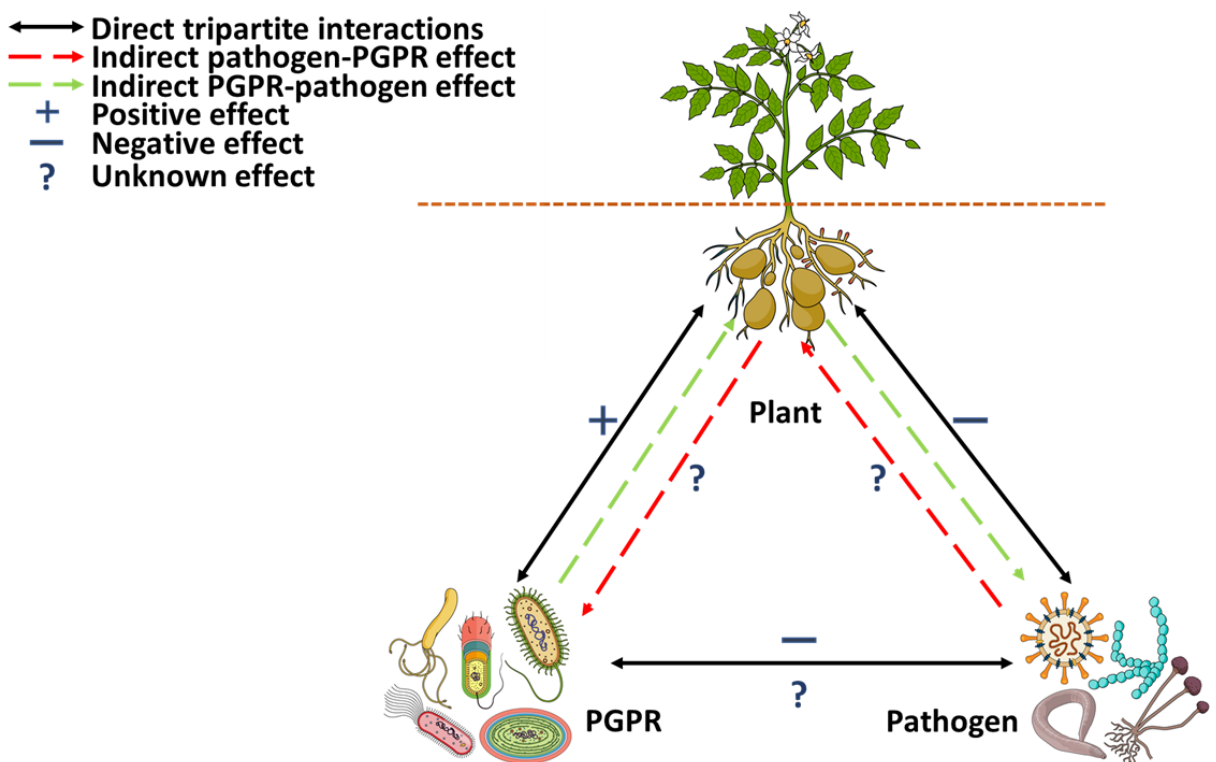
Figure 5. Direct and indirect tripartite interactions of plants, pathogens and PGPR. During direct tripartite interactions belowground (rhizospheric), plant – PGPR interactions result in positive effects on both parties; plant root exudates recruit and cater carbon-rich organic compounds for the proliferation of beneficial microbes (PGPR), while the microbes influence plant growth and protection. At the same time, plant – pathogen and pathogen – PGPR interactions result in negative and some unknown effects. Indirect tripartite interactions (ITI) are plant-mediated interactions between PGPR and aboveground pathogens. A negative effect on the plant by a pathogen (red dotted lines) triggers a physiological and metabolic change that causes the plant to recruit PGPR for defence. A response from the PGPR (green dotted lines) modifies the plant’s defence mechanism to improve resistance or tolerance against the foliar pathogen. Some of the underlying mechanisms of these interactions are not fully understood.